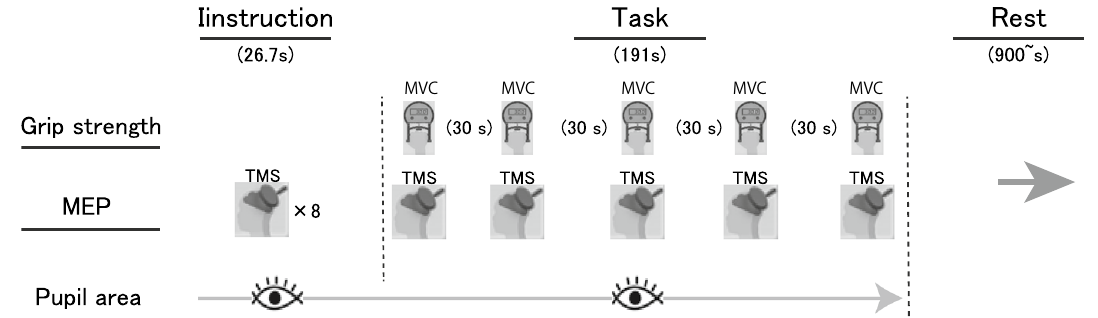
Figure 1. Experimental procedure. Each experiment consisted of two conditions (control and shout in MVC task phase), and each condition consisted of two phases (experimental instruction and MVC task). Each participant performed two conditions (control and shout) with a break of at least 15 min between each. The total experimental time was approximately 30 min. Instruction: experimental instruction phase. Task: MVC task